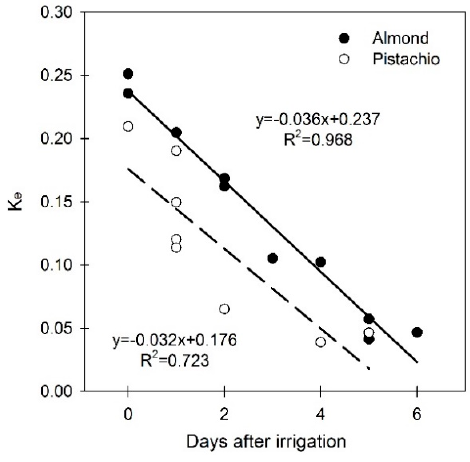
Figure 5. Relationship between the soil water evaporation coefficient (K e ) and the number of days after each irrigation event, in the almond (micro-sprinkler irrigation) and pistachio (drip irrigation) orchards. Table 2. Values of reference evapotranspiration (ET o ), rainfall, irrigation, modeled actual evapotranspiration (ETa model ) and transpiration (T model ), soil evaporation (E soil ) and ground cover crop water consumption (CC), all in mm, during the growing season (from DOY 61 to 335) for almond and